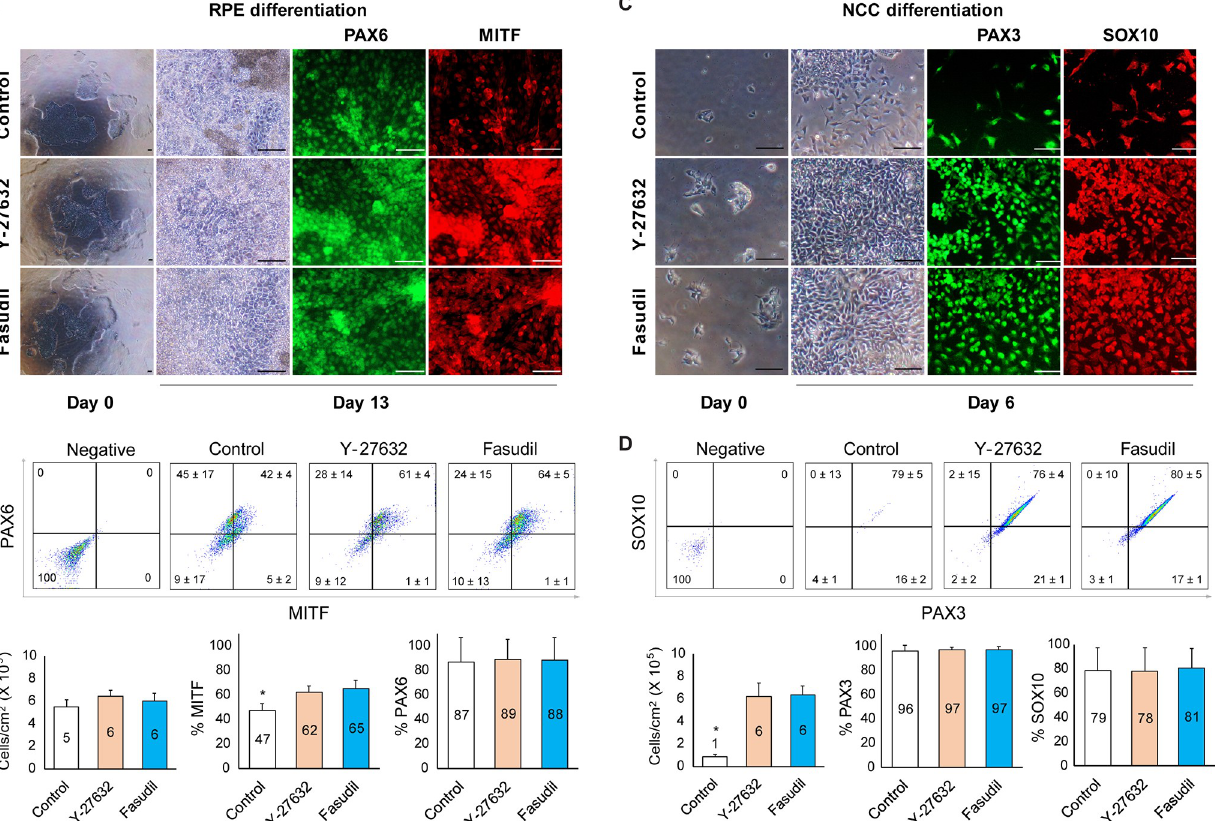
Fig 5. Fasudil promotes differentiation of PSCs. A: Expression of RPE-specific markers; PAX6 and MITF examined by immunocytochemistry (ICC) at 13 days. B: PAX6 and MITF positive cell populations analyzed by flow cytometry at 13 days. The percentage of PAX6 was similar in the groups, while MITF-positive cells were more frequent in the treated groups than in the untreated control ( � : p < 0.05, 3 replicates). Fasudil did not affect cell number in RPE differentiation. C: The expression of NCC markers; PAX3 and SOX10 by ICC. D: PAX3 and SOX10 positive cell population analysis using flow cytometry at 6 days. Fasudil promoted cell survival during NCC differentiation of hiPSCs ( � : p < 0.05, 3 replicates). RPE: retinal pigment epithelium, NCC: neural crest cell.